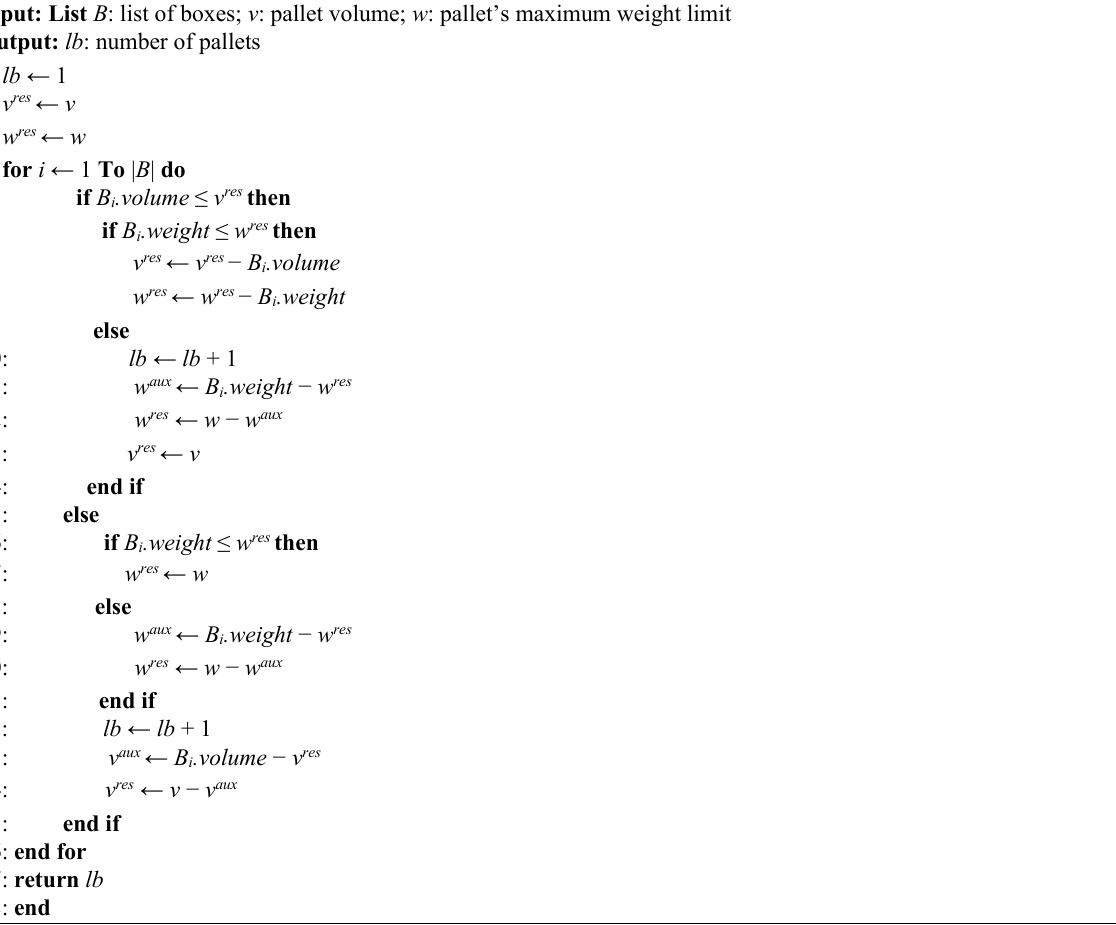
Algorithm 1 Lower Bound